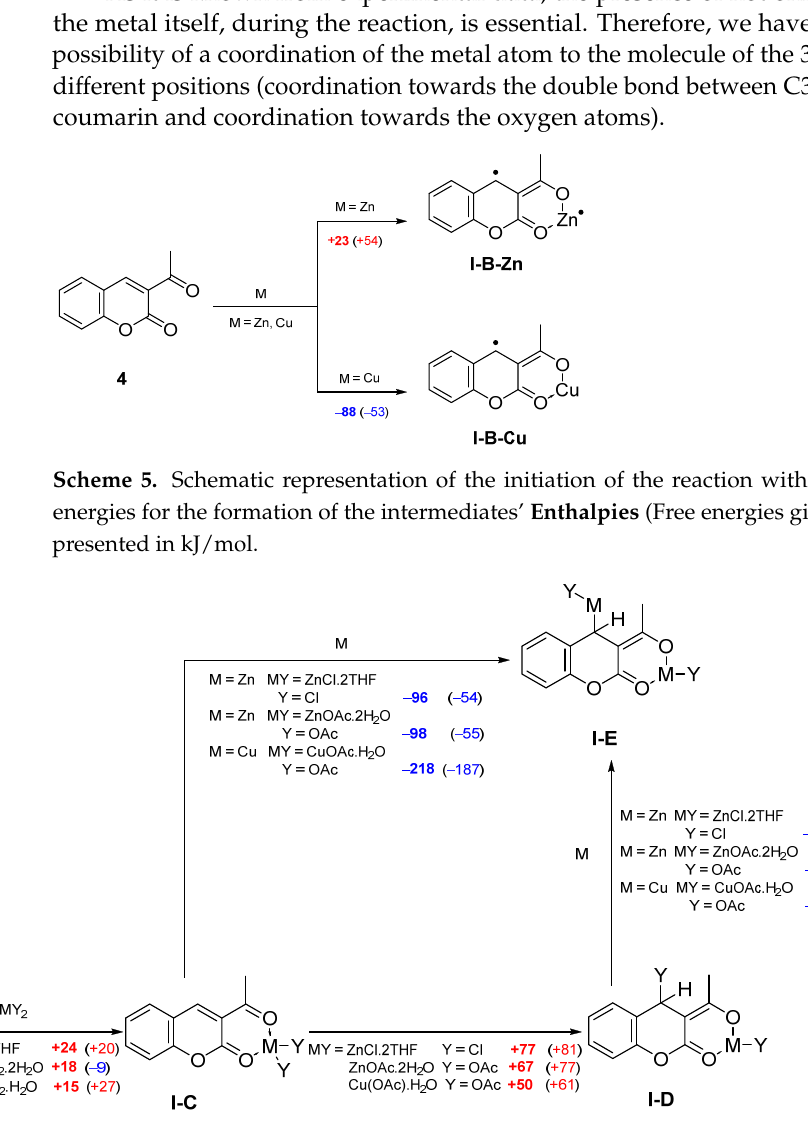
Scheme 6. Schematic representation of the ionic reaction mechanism. The Enthalpies (Free energies given in parenthesis) for the formation of the intermediates are presented in